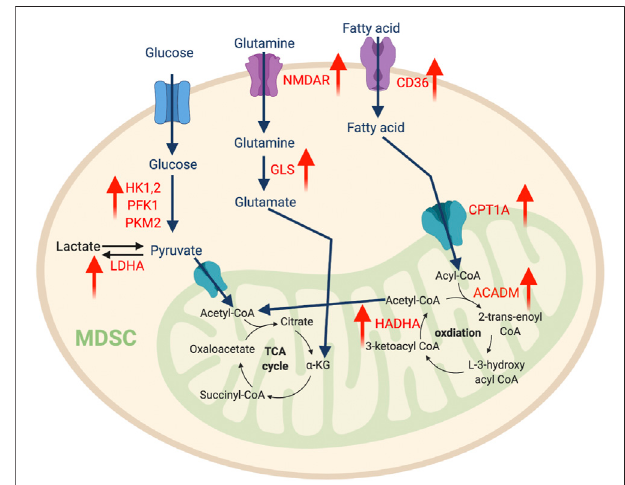
FIGURE 1 | The metabolic state and immune cells in tumor microenvironment. The altered metabolic activity of tumor cells creates an environment lacking oxygen, glucose and amino acid, and enriched with fatty acids. To adapt to this nutrient challenge, myeloid cells such as tumor- associated dendritic cells (TADC), myeloid-derived suppressor cells (MDSC), tumor-associated neutrophils (TAN), and tumor-associated macrophage (TAM) alter their metabolic program.